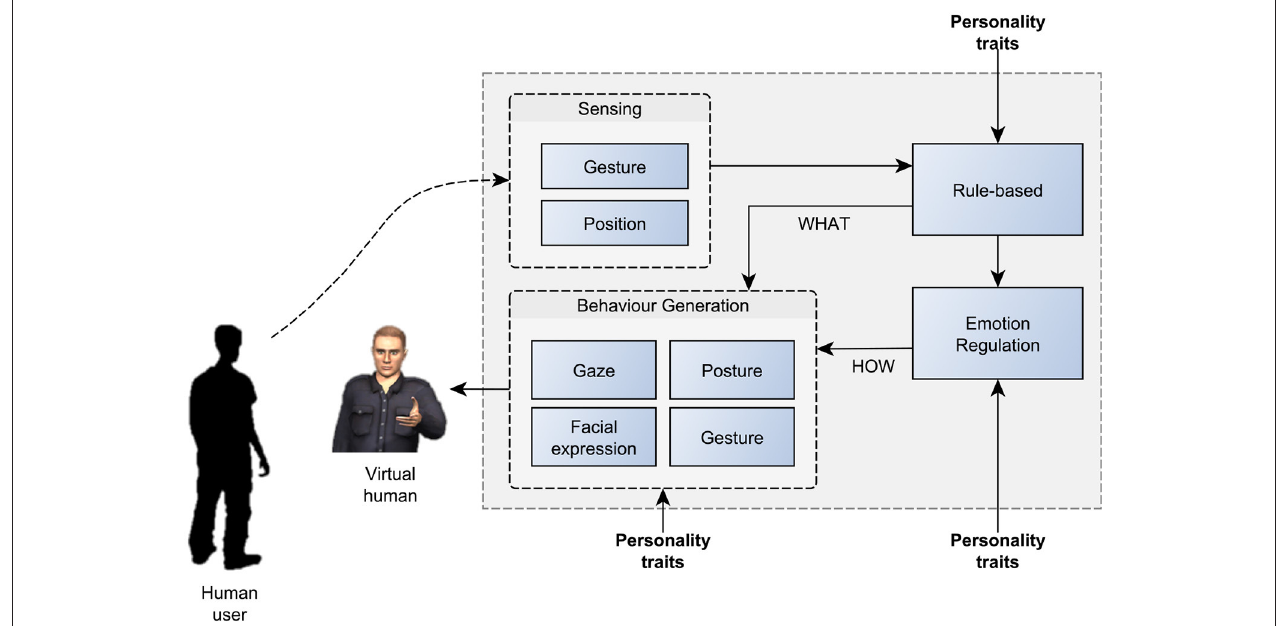
FIGURE 1 | The system architecture and how personality impacts its different modules. Personality traits affect the production of gestures, posture, gaze and facial